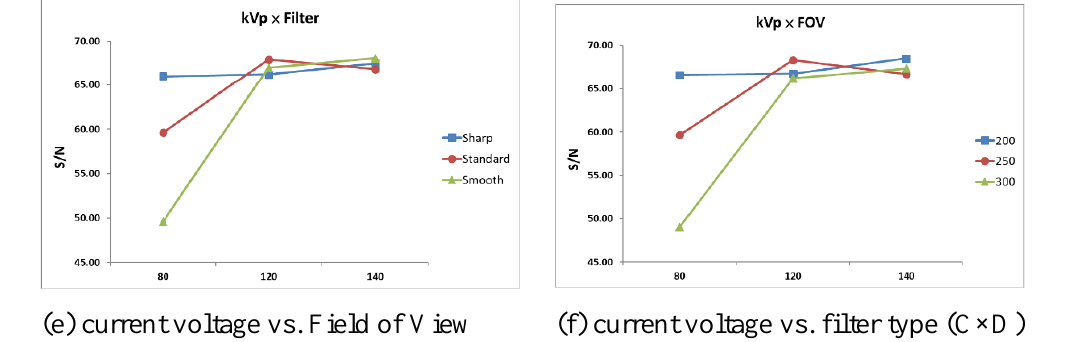
Figure 4. Six cross-interactions between pairs of parameters in the 128-slice CT acquisition experi- ments. ( a ) Thickness vs. filter type (A × D). ( b ) Thickness vs. current voltage (A × C). ( c ) Thickness vs. FOV (A × E). ( d ) Filter type vs. FOV (D × E). ( e ) Current voltage vs. FOV (C × E). ( f ) Current voltage vs. filter type (C ×